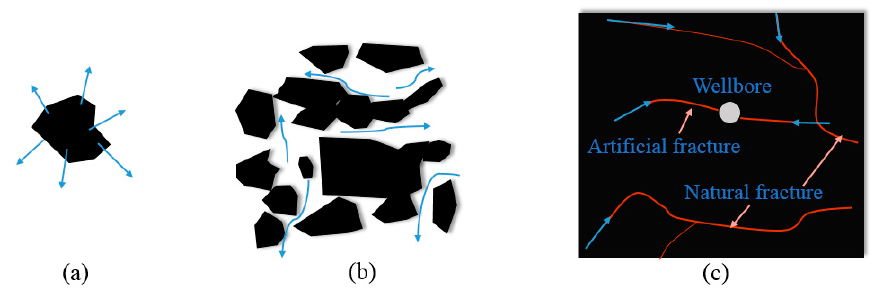
Figure 1. Desorption and migration of CBM: ( a ) desorption from surface; ( b ) migration in pores and fractures; ( c ) flowing into the well bore through fractures.